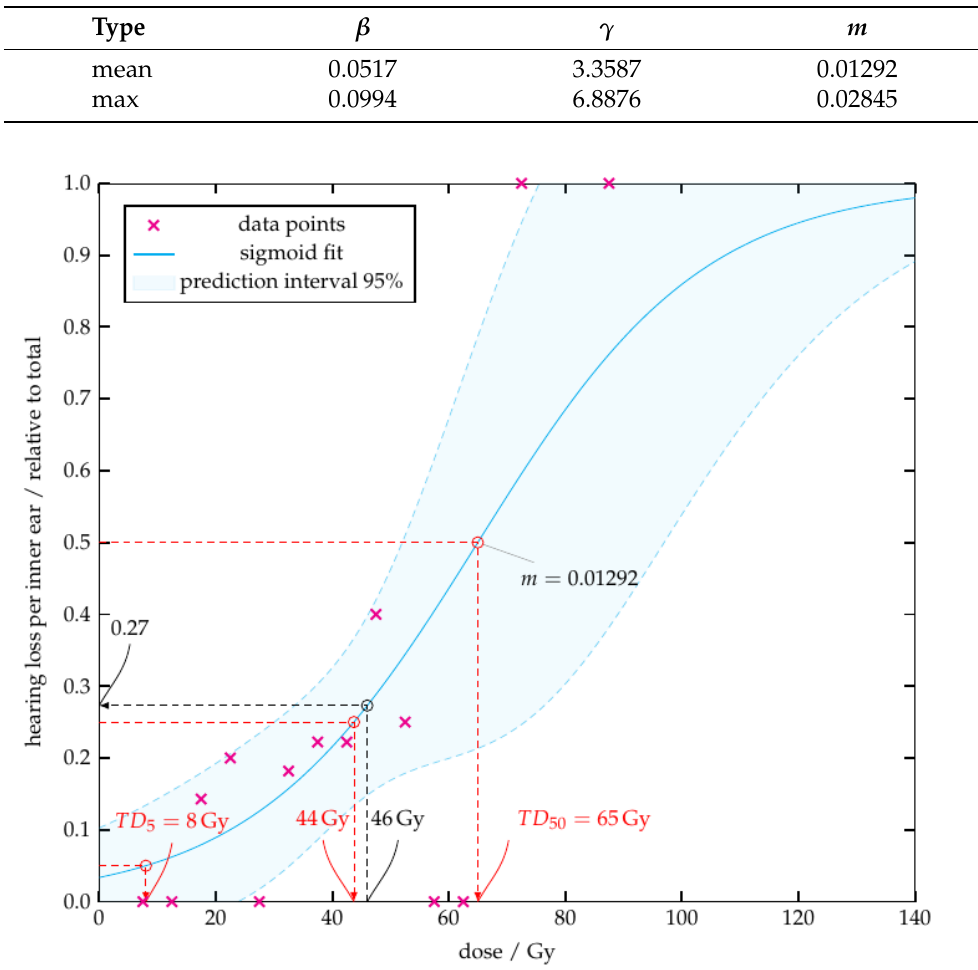
Table 5. estimated regression parameters.